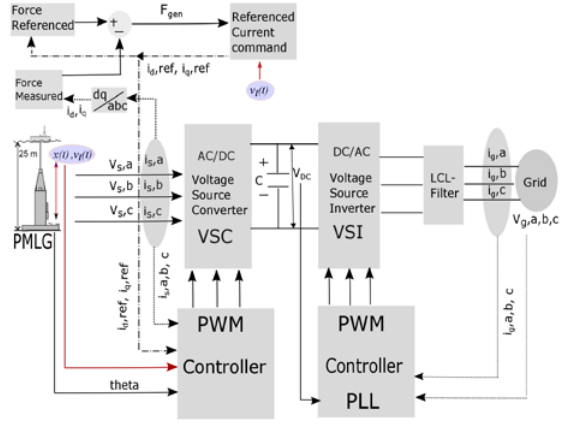
Fig. 2. Block diagram of the system with a heaving